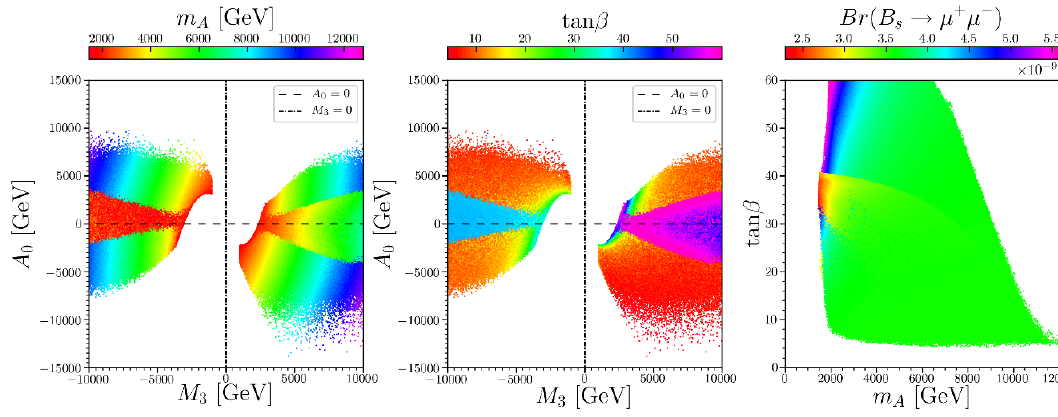
Figure 2 . Surviving samples in the A 0 versus M 3 (left and middle), tan (cid:12) versus the CP-odd Higgs mass m A (right) planes. The colors indicate m A (left), tan (cid:12) (middle), and Br ( B s ! (cid:22) + (cid:22) (cid:0) ) (right), respectively. In these 2-dimension planes, larger-(cid:1) a (cid:22) samples are projected on top of smaller